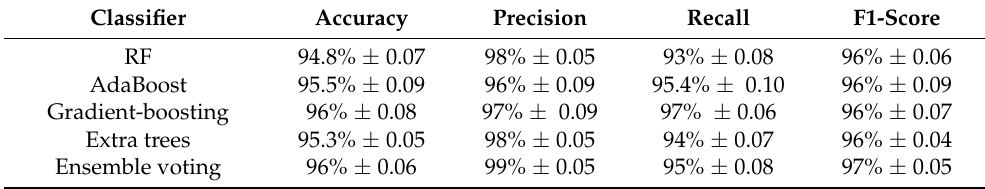
Table 2. Results of all machine learning models using the five fold cross-validation